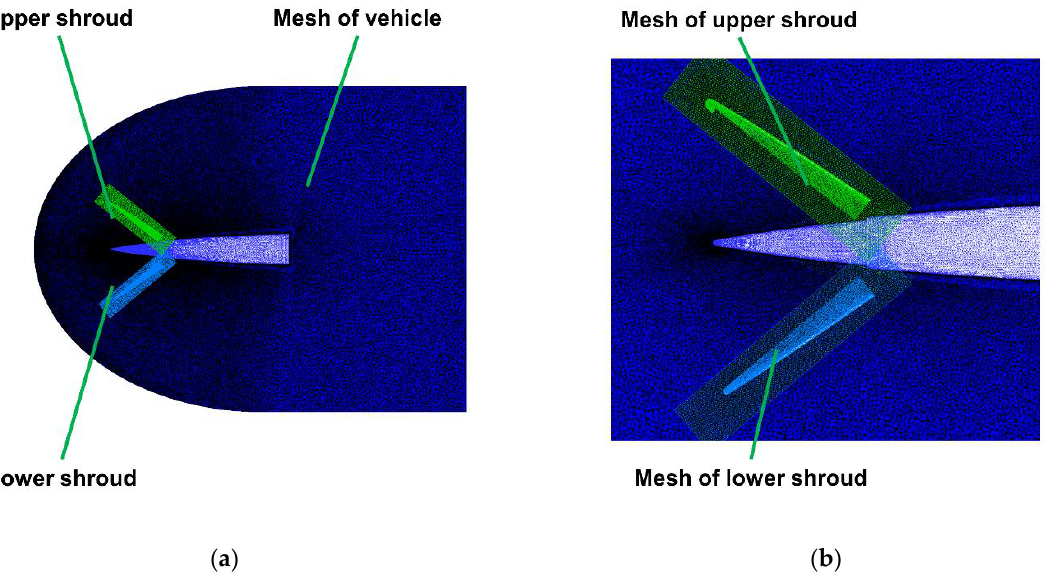
Figure 7. The overset mesh of shroud separation: ( a ) the three sub-meshes of shroud separation; ( b ) the grid distribution of the separation area.